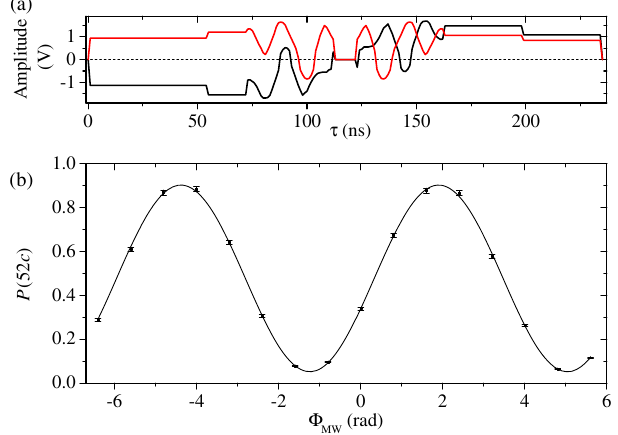
FIG. 6. Coherence test. (a) Evolution of the control voltages V τ Þ (black line) and V τ Þ (red line) in the sequence that tests r ð i ð the coherence of the optimized circularization pulse. We first apply a time-reversed optimized pulse followed by a circulari- zation pulse similar to that of Fig. 2(b). The flat parts of the pulses ( 0 ≤ τ ≤ 73 and 163 ≤ τ ≤ 236 ns) are now divided in two steps, ensuring that the reference 50 c level is transferred back into itself by each pulse. (b) Probability to finally detect the atoms in 52 c as a function of the relative phase between the MW Ramsey pulses. The points are experimental with statistical error bars, the solid line is a sine fit. The visibility [89.1(6)%] is excellent, limited mostly by the technical electric field noise in the